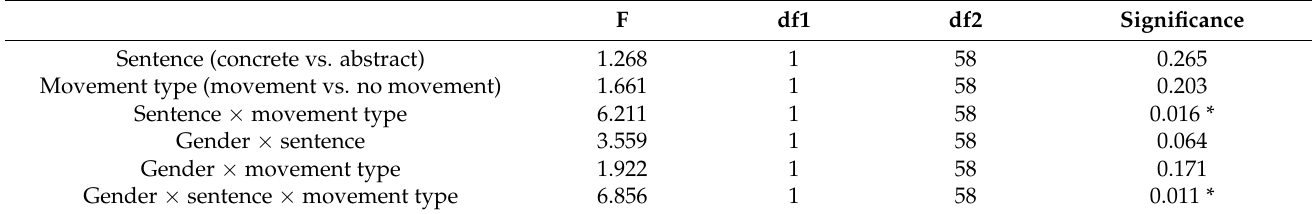
Table 2. Results of a 2 × 2 repeated measures ANOVA for the decision times (ms) with gender as a covariate. * = p < 0.05. F df1 df2 Sentence (concrete vs. abstract)